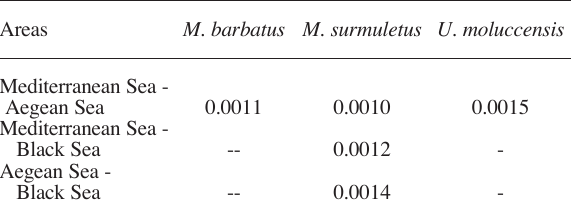
T ABLE 2. – Values of the genetic distance based on 17 putative loci for all pairwise comparisons between the populations of sampled areas for each species as illustrated in Areas